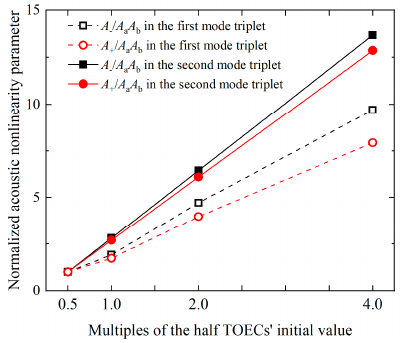
Figure 15. For the nonlinear interaction of S 2 and S 3 mode in experiments, the relationship of nor- malized acoustic nonlinearity parameters